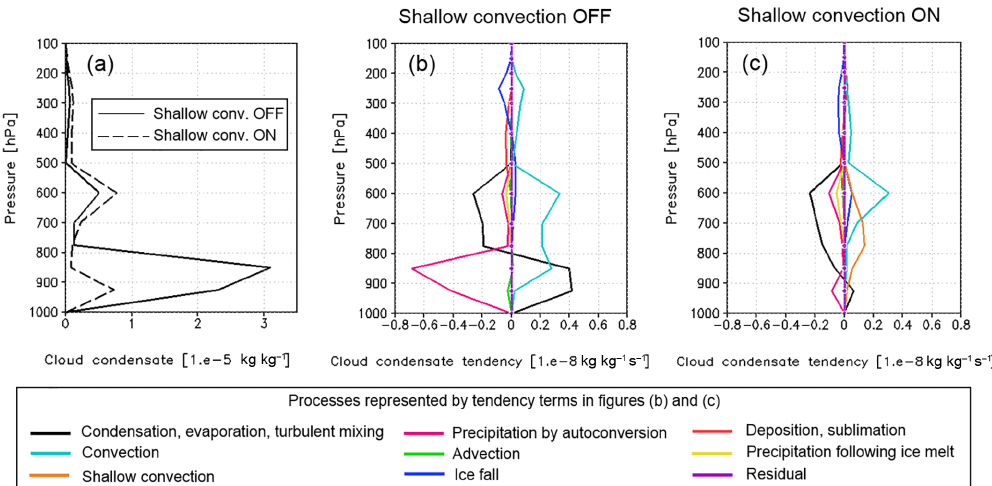
Figure 10. Vertical profile of annual mean (a) cloud condensate and (b, c) cloud condensate tendencies in the eastern tropical Pacific simu- lated by the MIROC5 AGCM. The data are from the grid point located at (114 ◦ W, 5 ◦ S), indicated by the black square in Fig. 9. (a) Cloud condensate simulated without shallow convection parameterization (solid line) and with the parameterization (broken line), (b) cloud con- densate tendencies simulated without shallow convection parameterization, and (c) cloud condensate tendencies simulated with the parame-